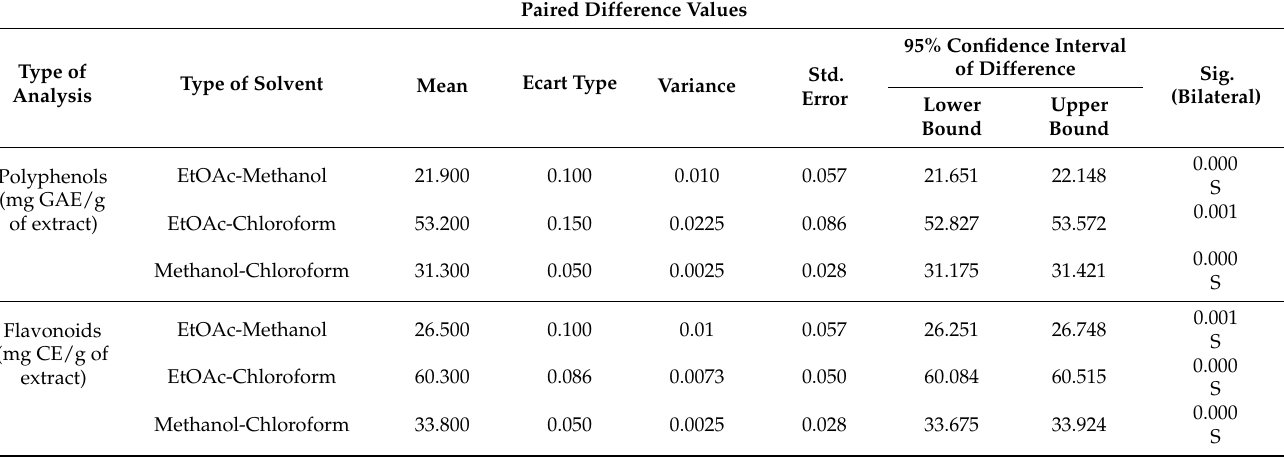
Table 6. Statistical analysis performed by a paired difference test. Paired Difference